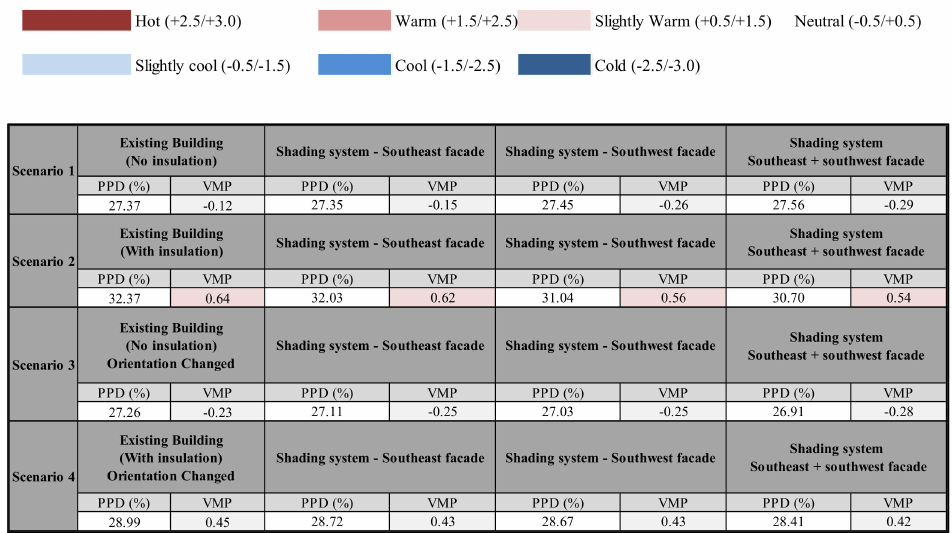
Figure 20. Annual average calculation: predicted percentage dissatisfied (PPD) and predicted mean vote (PMV).